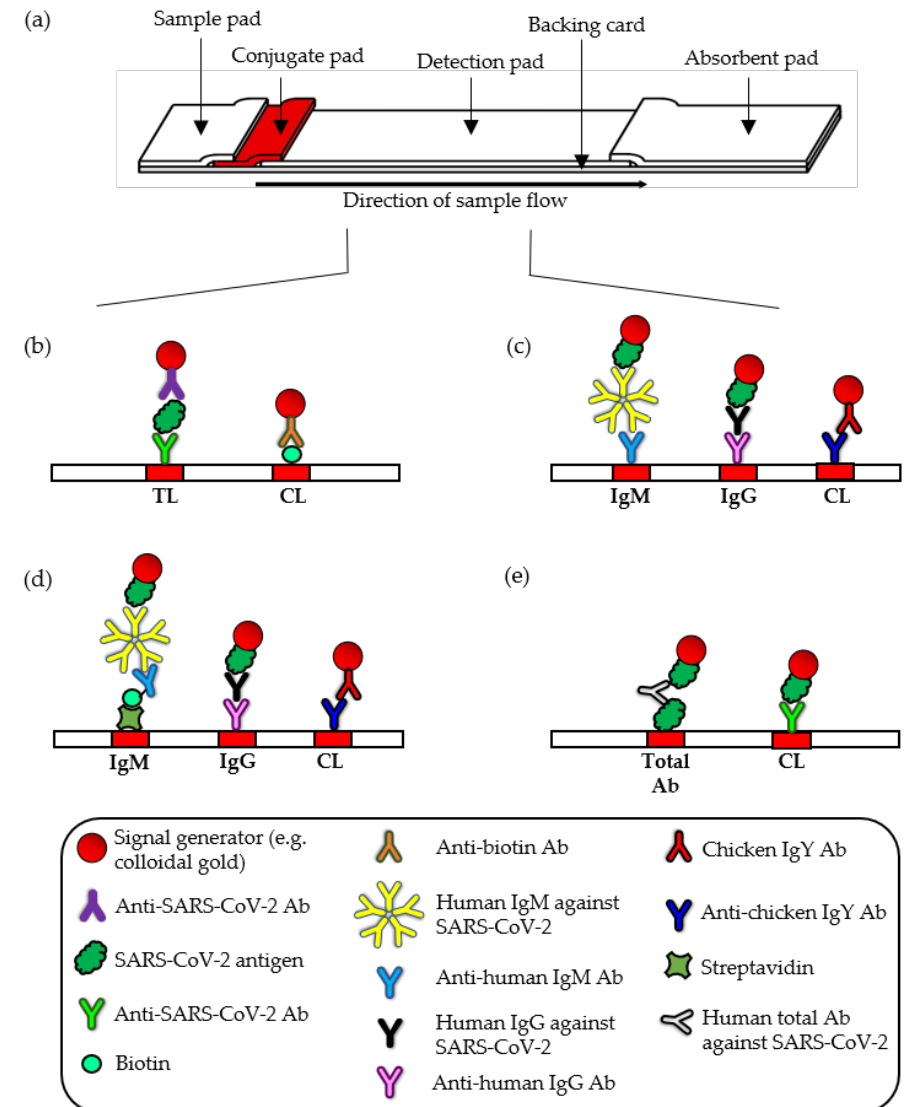
Figure 1. ( a ) Assembly of the different components of LFI. Assay formats for the detection of SARS- CoV-2 antigen ( b ), IgM and IgG ( c , d ), and total antibody ( e ). TL, test line; CL, control line; Ab, antibody.